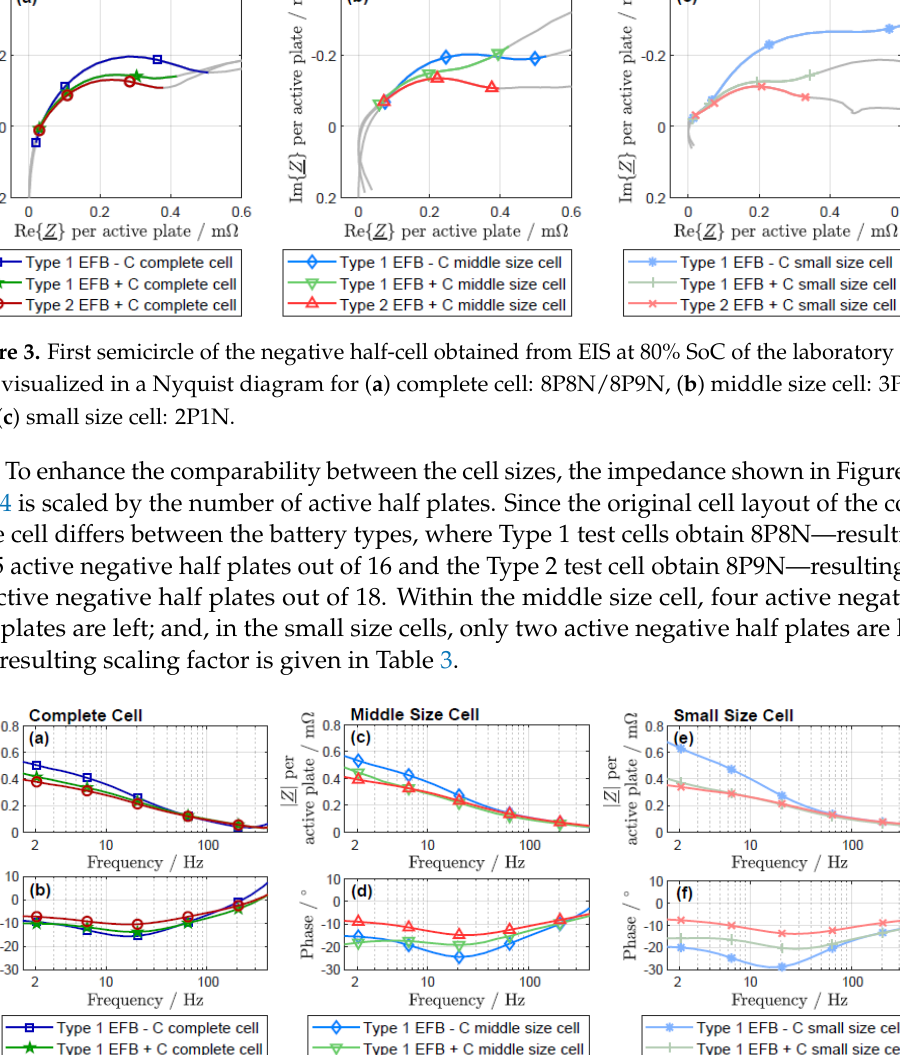
Figure 4. Negative half-cell EIS at 80% SoC of the laboratory test cells for ( a ) absolute value Z of the complete cell: 8P8N/8P9N, ( b ) phase shift of the complete cell: 8P8N/8P9N, ( c ) absolute value Z of the middle size cell: 3P2N, ( d ) phase shift of the middle size cell: 3P2N, ( e ) absolute value Z of the small size cell: 2P1N and ( f ) phase shift of the small size cell: 2P1N visualized in a Bode plot.